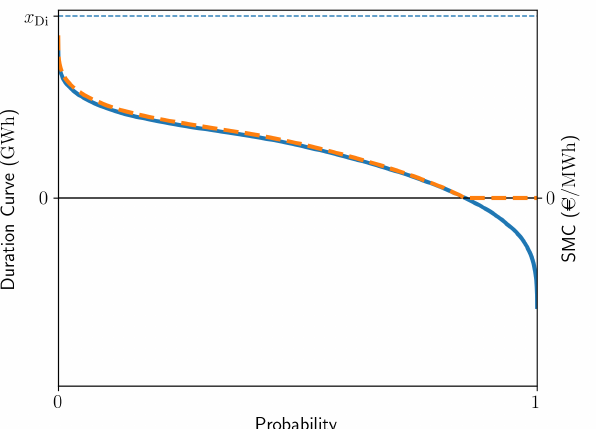
Figure 1. Illustration of the system marginal cost (thick dashed orange line) dependence on the residual load (thick plain blue line) expressed by Equation (9) for an optimal solution. The load is represented as an load duration curve. That is, the load values are ranked by decreasing values and given as a function of the probability that the load exceeds a particular load